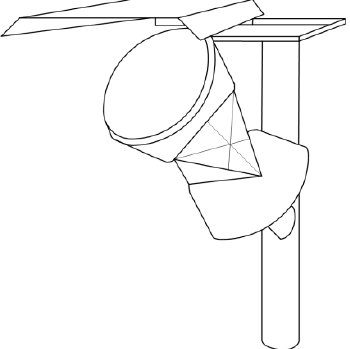
Figure 2. Schematic diagram of observation signs